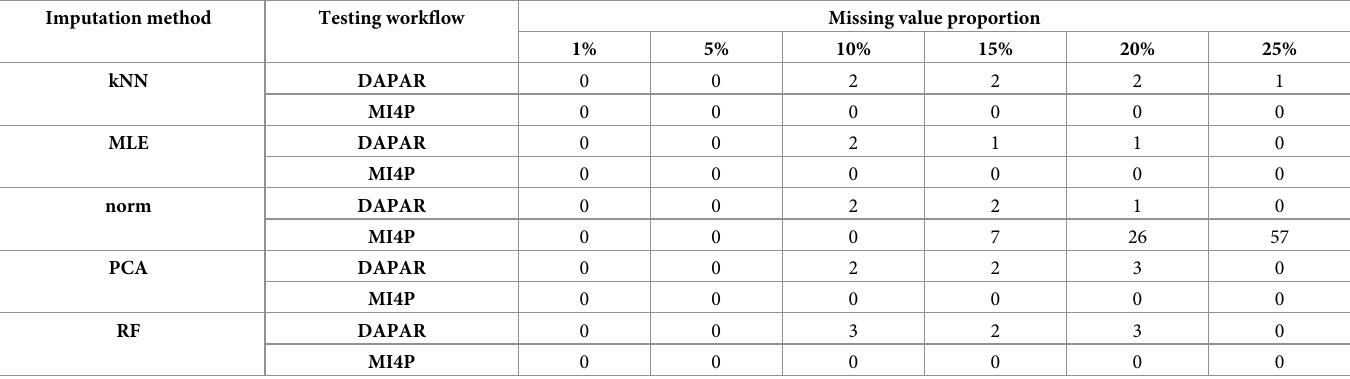
Table 2. Number of pathological cases for each missing value proportion in the second set of MAR